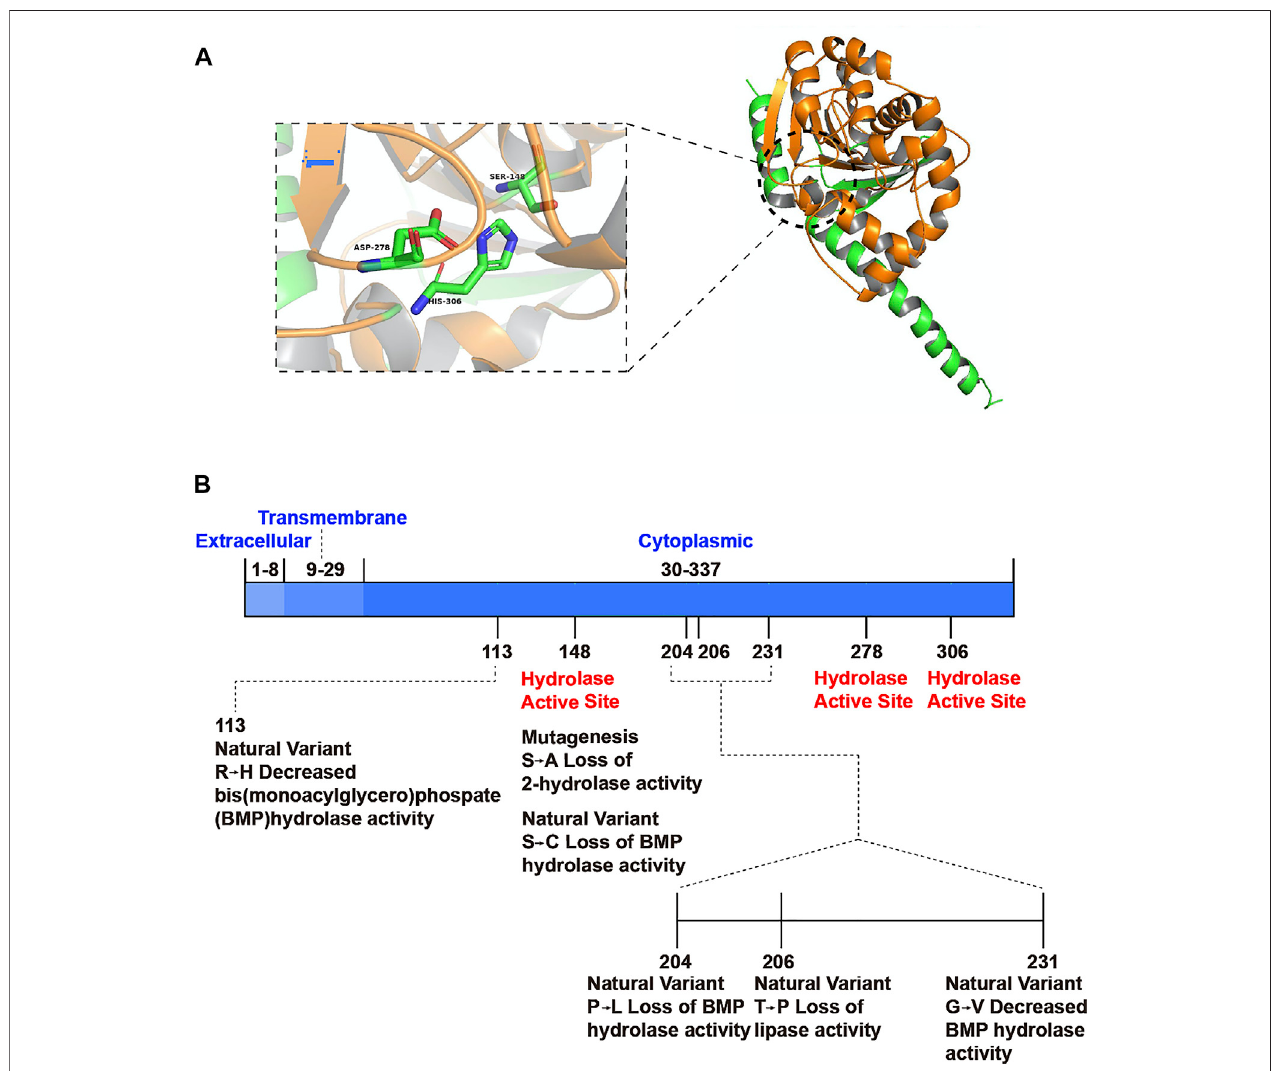
FIGURE1| SpatialstructuremodelofABHD6anditsfunctionalsites. (A) ABHD6consistsofaneightchain β -sheetwithsurrounding α -helices.Thecatalytictriadis composed of a nucleophilic residue (Ser148), an acidic residue (Asp278) and a histidine (His306). (B) Mutation or natural variation may occur at some sites of ABHD6, resulting in the decrease or loss of partial hydrolytic function of the enzyme. There is no document report that ABHD6 has modi fi cation sites on protein structures.